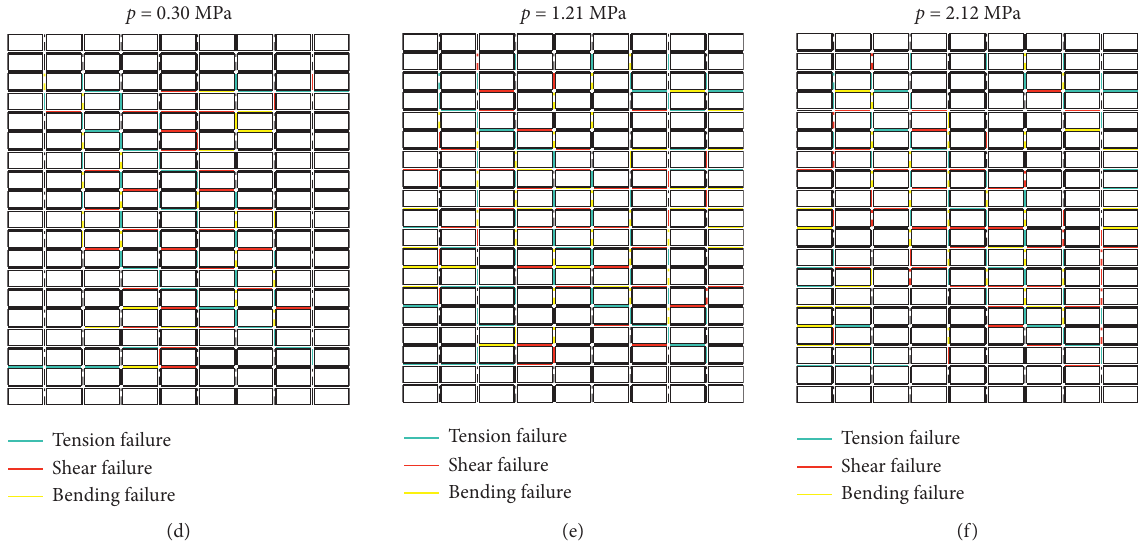
Figure 6: Deformed configurations (a, b, and c) and interface damage (d, e, and f); continuous lines, mortar interfaces and dashed lines, inner block interfaces) at d � 2 mm of the numerical shear tests with varying compression.